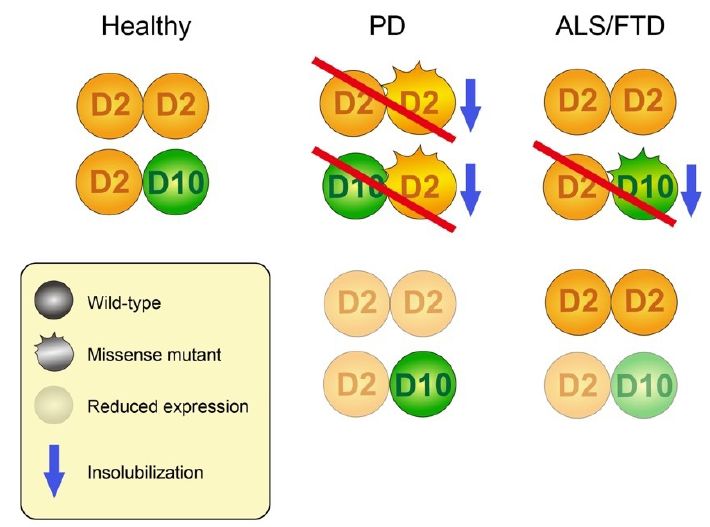
Figure 6. Working hypothesis showing that CHCHD2 and CHCHD10 produce a complicated disease spectrum. CHCHD2 forms a homodimer and stimulates heterodimerization with CHCHD10, which may be important to maintain mitochondrial activity [50,57]. In PD, CHCHD2 T61I mutation facilitates its insolubilization, which should involve the partners [50,57]. Splice-site mutation (c.300 + 5G > A) of CHCHD2 and variants in the untranslated region may reduce CHCHD2 expression [7,32]. In both cases, functional CHCHD2 is reduced. In ALS–FTD, CHCHD10 G59L and G66V mutations facilitate their insolubilization, which should involve wild-type CHCHD2 [57]. Variants in the untranslated region of CHCHD10 or truncated CHCHD10 mutants that cannot bind to CHCHD2 may also cause pathogenesis due to haploinsufficiency, although there are no experimental data so far. In both cases, the CHCHD2 homodimer will be intact.